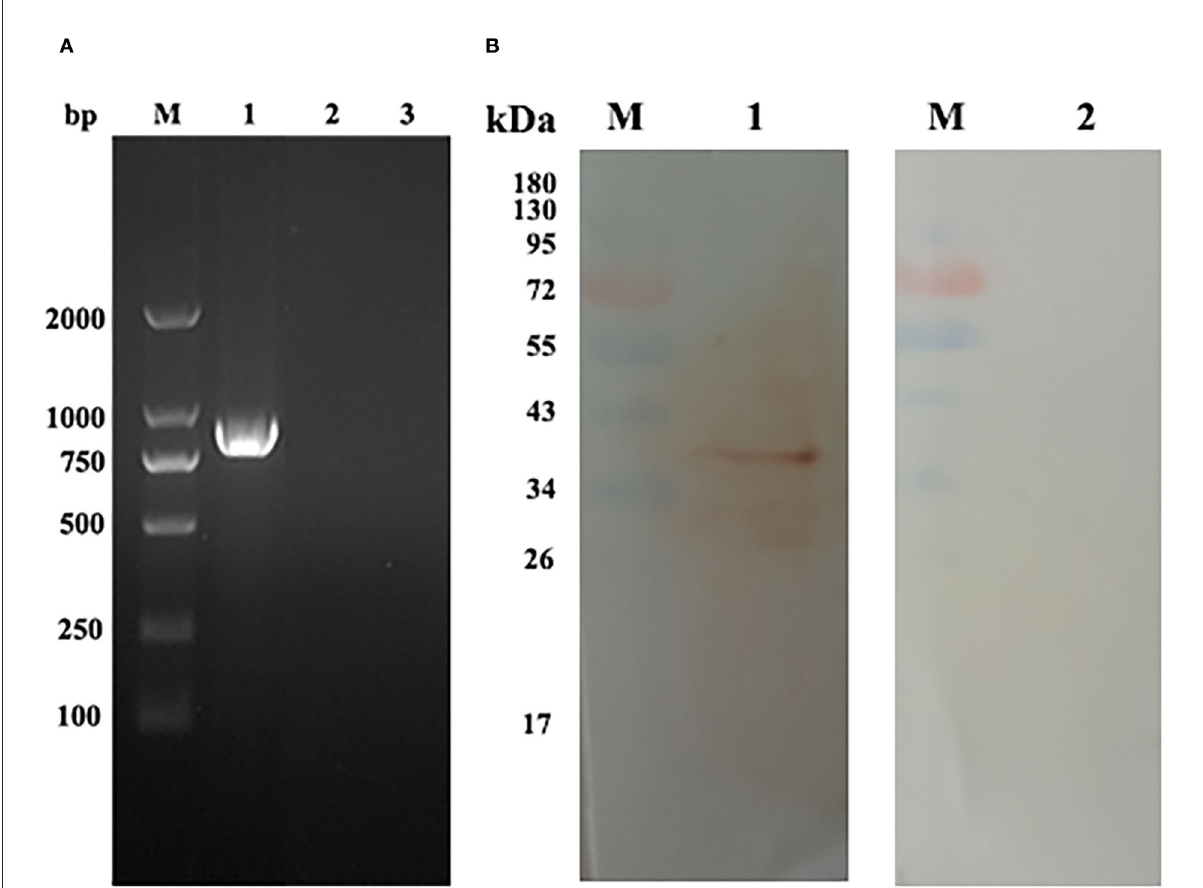
FIGURE3 Transcription and expression of pEmROM1 in the injected muscles in chickens. (A) Transcription detection of pEmROM1 in chickens by RT-PCR. M: DNA molecular weight standard DL 2000. Lane 1: PCR product of EmROM1 detected from the pEmROM1 injected muscles. Lane 2: Detection of pVAX1.0 vector injected muscles. Lane 3: Detection of non-injection sites. (B) Expression detection of pEmROM1 in chickens by Western blotting. M: protein standard molecular weight. Lane 1: Detection of EmROM1 from the pEmROM1 injection site by anti-rEmROM1 rat serum. Lane 2: Negative rat serum